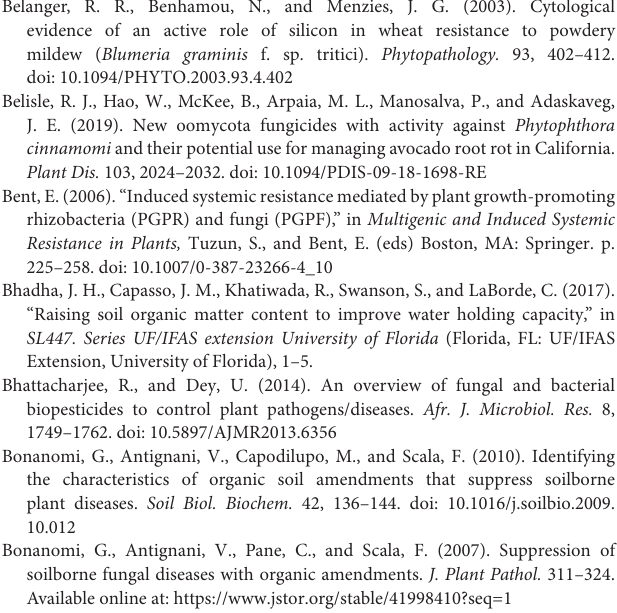
indicates those infested with Phytophthora cinnamomi and -Pc indicates non-infested. Supplementary Table S1 | The effect of four soil treatments on shoot dry weight, total root dry weight, fine root dry weight and root damage of non-infested avocado plants or those infested with Phytophthora cinnamomi . Significant differences between means for each growth parameter are indicated by different superscript letters. For each parameter, means for non-infested and infested plants in the same treatment that are significantly ( P < 0.05) different are shown in bold. Root damage scores are 1 (least damaged) to 5 (most damaged). Data from Farooq et al. (2022). Supplementary Data Sheet S1 | (A) A comparison of the bacterial communities present ( OTU s) and relative abundance within a particular classification (up to genus level) in non-infested and infested rhizospheres (for each of the four treatments) for which the abundance changed significantly following infection. Significance of differences were assessed by a Mann-Whitney (Wilcoxon) test with significant differences having P < 0.05. “-” indicates that the relative abundance at infested rhizosphere had a significantly lower relative abundance than in non-infested rhizosphere, when collapsed to the particular classification level, while a “ + ” indicates a significantly higher abundance at non-infested rhizosphere, respectively. The columns “n-” ad “n + ” refer to the number of OTUs within a genus where an infested rhizosphere had a significantly lower (-) or higher ( + ) relative abundance, respectively. (B) A comparison of the relative abundance of bacterial communities within a particular classification present in the rhizosphere of non-infested pots with only organic mulch and those with, in addition, mineral mulch or in which plants were treated with phosphite. The columns “n-” and “n + ” refer to the number of OTUs within a genus where organic mulch treatment had a significantly lower (-) or higher ( + ) relative abundance, than the mineral mulch or phosphite treatments,